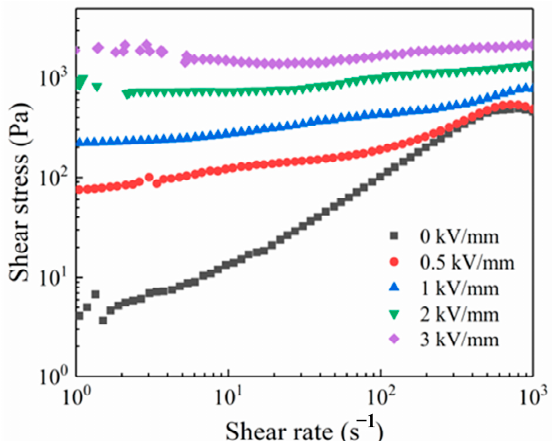
Figure 5. Rheological curve of alumina-doped titanium dioxide ER polishing fl uid under di ff erent electric fi eld intensity (volume fraction = 20%, T = 25 °C).